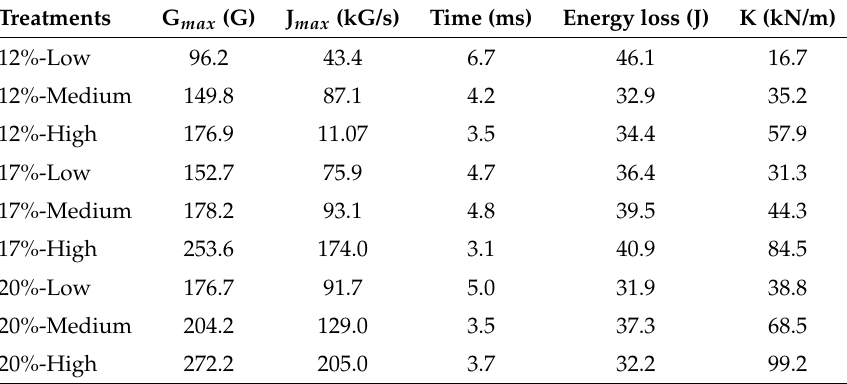
Table 2. Impactdata from conducting a drop test on the sand